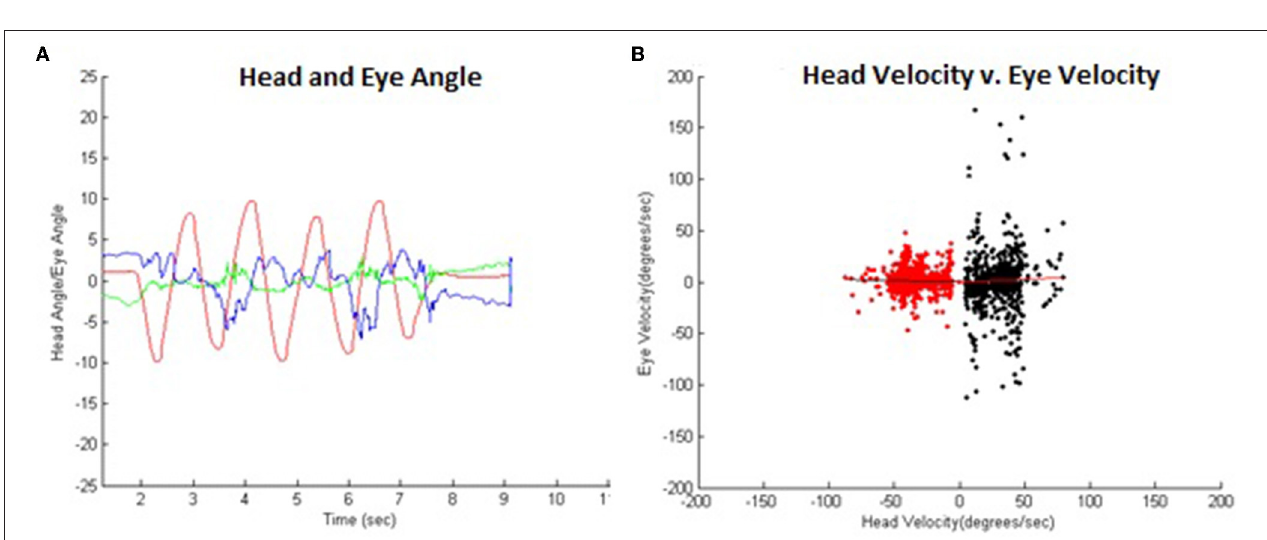
FIGURE 3 | (A) Typical example of VOR suppression temporal head (red), right eye (blue), and left eye (green) angle data. (B) These same data comparing head vs. eye angular velocity illustrating VOR suppression. Leftward (black) and rightward head movements (red) are separated for analysis with head velocities below 5 ◦ /s excluded since the VOR response is negligible at low head velocities. The VOR gain was approximately zero in this